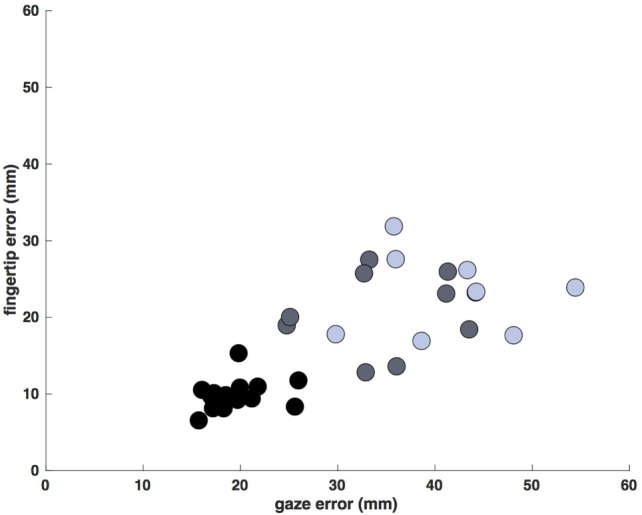
Average saccade vs. reach endpoint error (mm at the screen). Each data point is the average error for a single participant/arm (control movements: black, less-affected arm: gray, more-affected arm: blue). Errors display a dependence on arm motor impairment, generally increasing across participants from control to stroke, and from less- to more-affected limbs (r = 0.76, p < 0.05).